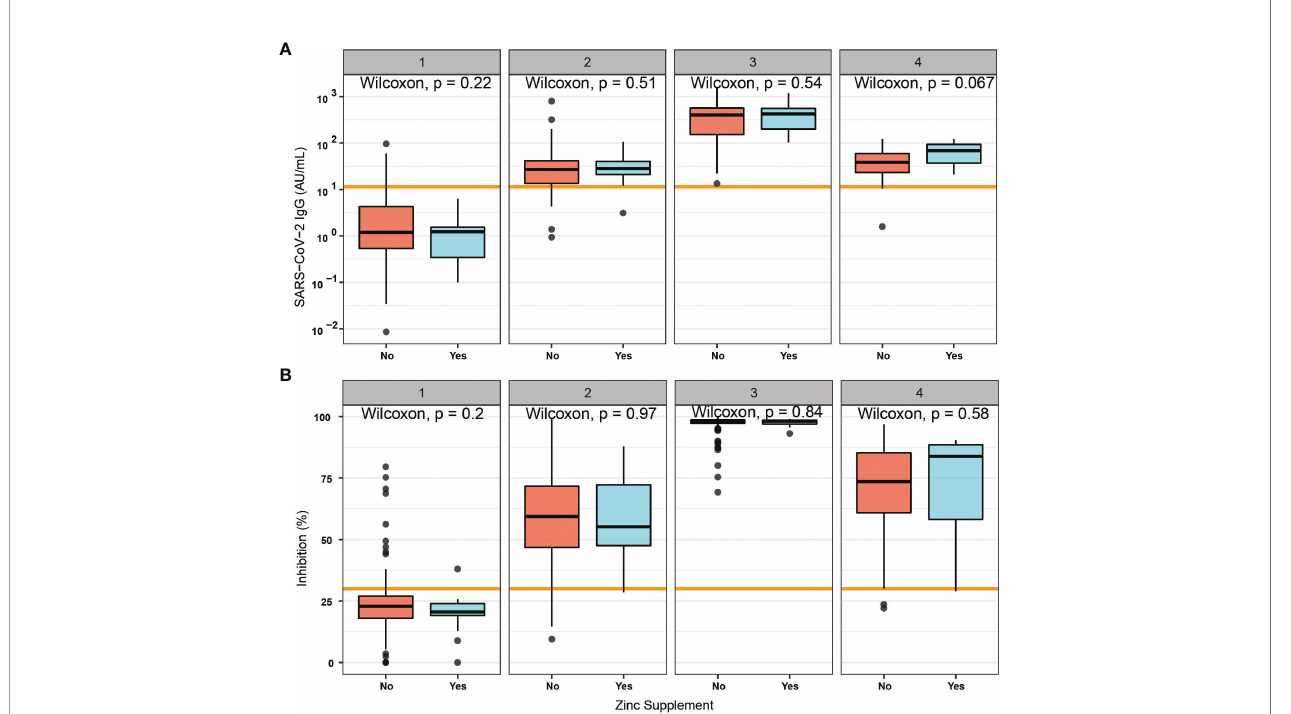
FIGURE 4 | Vaccination response in relation to self-administered supplemental Zn intake. A subset of probands reported no (No) or active (Yes) self-administered intake of Zn-containing supplements during the study. Immune responses measured by (A) total antibody concentrations to SARS-CoV-2, or by assessment of (B) binding inhibition were not signi fi cantly different between the two groups. Pairwise comparisons were conducted by applying the Wilcoxon-Rank-Sum